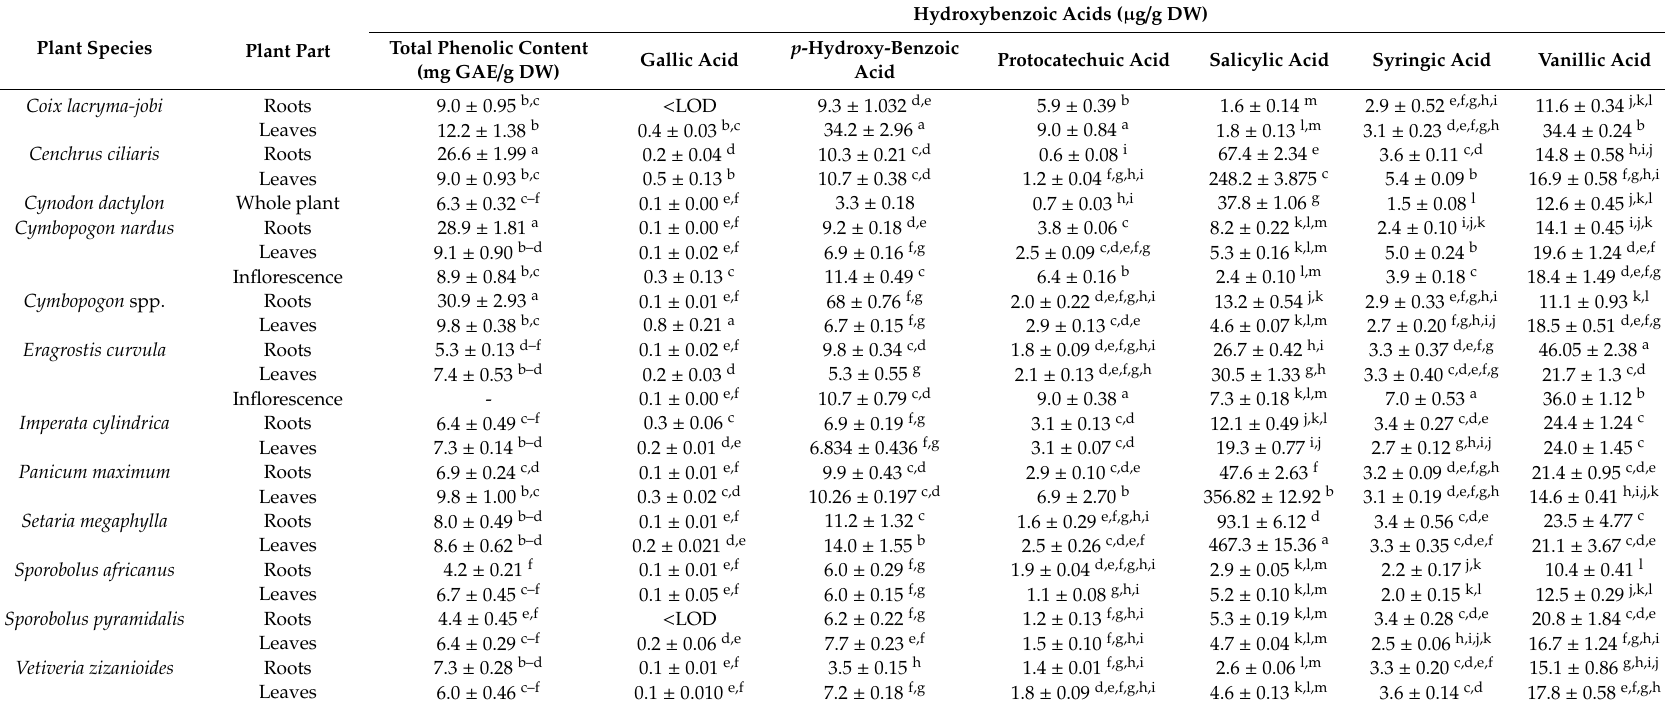
Table 1. Concentrations ( µ g / g DW) of hydroxybenzoic acids in 80% methanolic extracts of grasses used in South African traditional medicine. Values represent mean ± standard error, n = 3. In each column, values with di ff erent letter(s) are significantly ( p ≤ 0.05) di ff erent, based on Duncan’s multiple range test (DMRT). < LOD = below level of